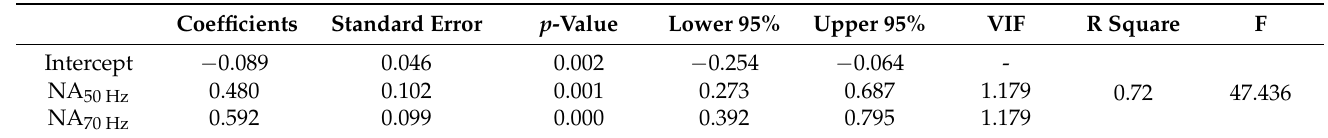
Table 2. Results of regression analysis of the net-to-gross ratio and frequency division amplitude in SS2